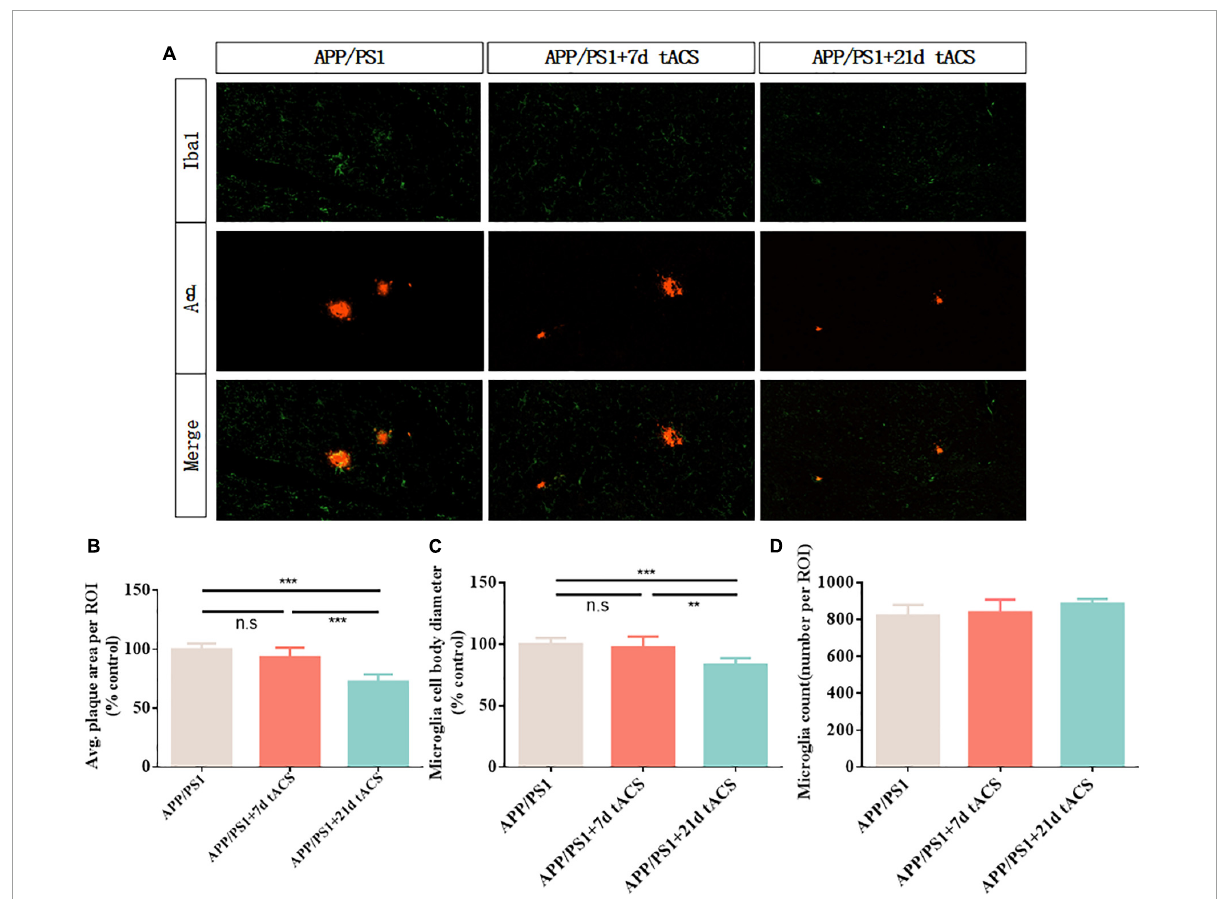
FIGURE7 Transcranial alternating current stimulation induces a microglial response in the hippocampus of APP/PS1 mice. (A) Immunohistochemistry with anti-Iba1 and anti-A β antibodies in the hippocampus of APP/PS1 mice. (B) Average area of A β -positive plaques in the hippocampus. (C) Diameter of Iba1-positive microglial cell bodies in the hippocampus. (D) Number of Iba1-positive microglia in the hippocampus. ** Indicates P < 0.01,*** indicates P < 0.001. n = 5 mice for each group. The marks in the diagram represent data points. The A β area of mice in 7 days tACS group was 96% ± 2.1% of that of APP/PS1 group. The A β area of mice in 21 days tACS group was 77% ± 6.9% of that of APP/PS1 group. The microglia diameter of mice in 7 days tACS group was 98% ± 1.6% of that of APP/PS1 group. The microglia diameter of mice in 21 days tACS group was 81% ± 5.3% of that of APP/PS1